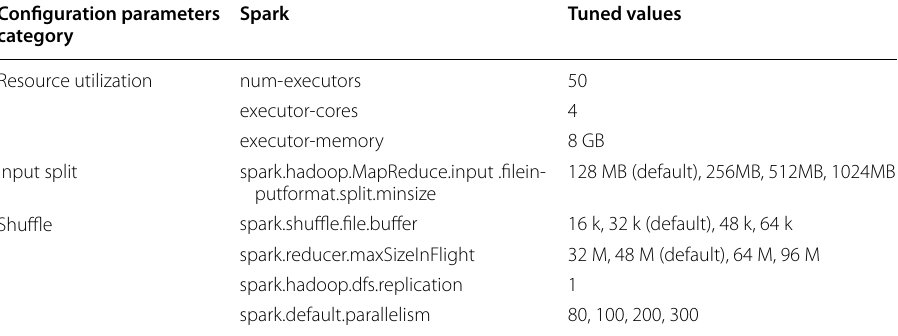
Table 4 Spark configuration parameters Configuration parameters